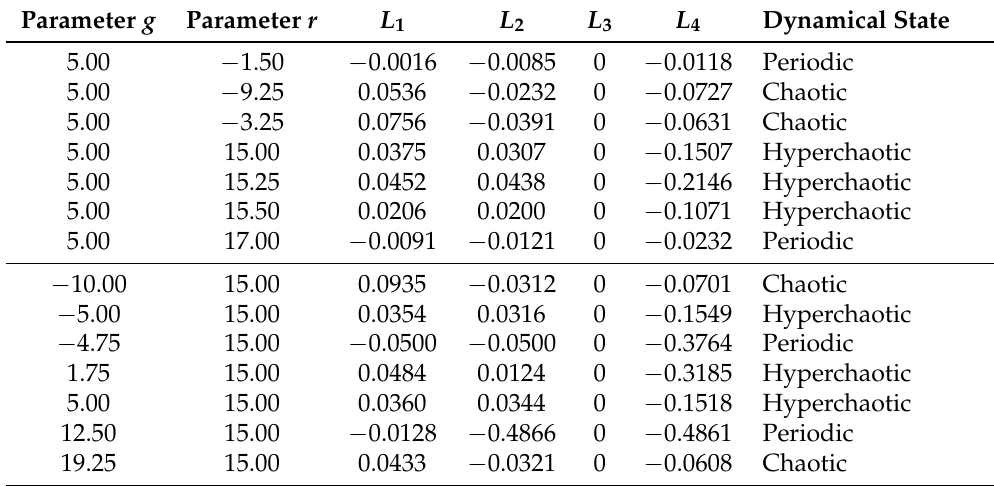
Table 2. Selected Lyapunov exponents for the hyperchaotic fractional-order system of (4) when (i) g = 5 was fixed and r varies, and (ii) when r = 15 was fixed and g varies.